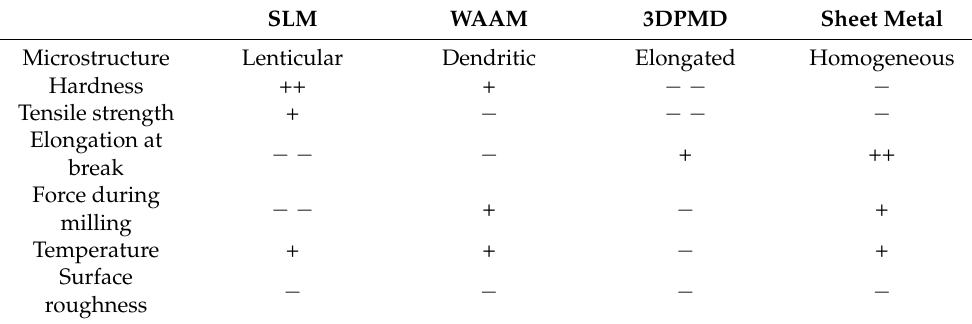
Table 2. Qualitative overview of the results. SLM WAAM 3DPMD Sheet Metal Microstructure Lenticular Dendritic Elongated Homogeneous Hardness ++ + − − − Tensile strength + − − − − Elongation at − − − + ++ break Force during − − + − + milling Temperature + + − + Surface − − − roughness